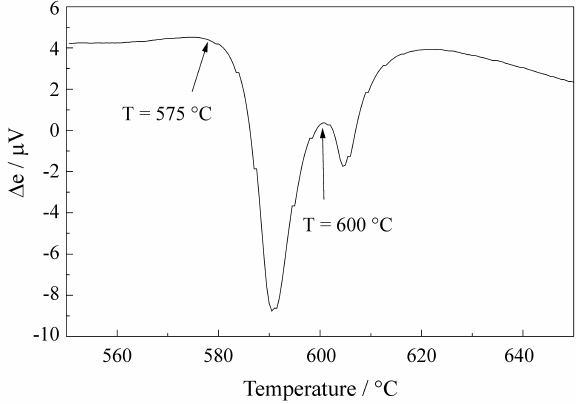
showing crystallization events corresponding to Fe 3 B and Pr 2 Fe 14 B.